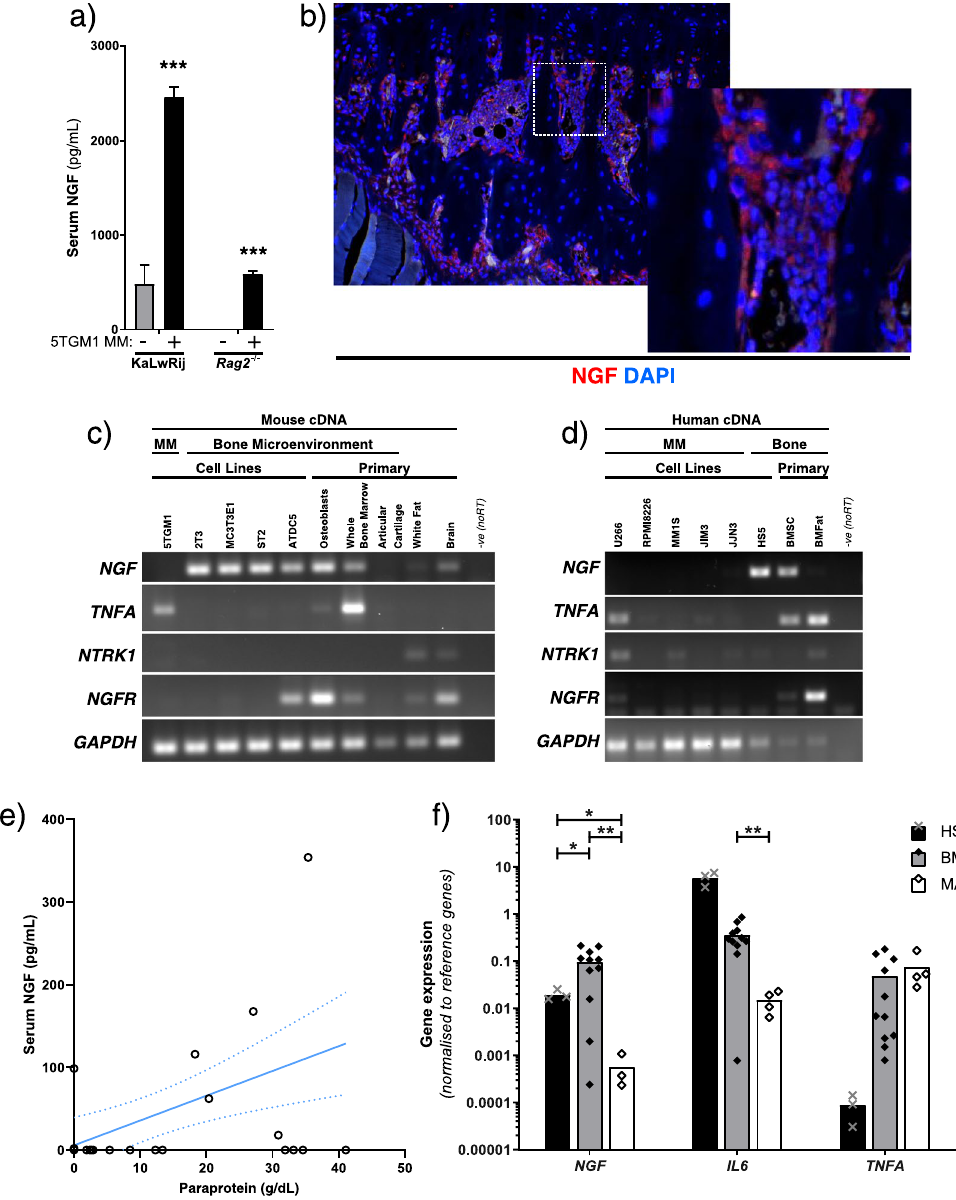
Figure 1. Increase in pain-related factors in multiple myeloma. ( a ) Serum NGF was detected by ELISA before inoculation or 25 days after 5TGM1-GFP + inoculation of C57Bl6/KaLwRij or Rag2 − / − mice. Statistical comparisons by t -test with Holm-Sidak multiple comparisons correction. ( b ) Immunofluorescent detection of NGF (red channel) in tibia of KaLwRij mice, counterstained with DAPI (blue channel). Magnified inset image corresponds to dashed box. ( c ) RT-PCR for mouse NGF , TNFA , NTRK1 (TrkA), NGFR (p75NTR) and GAPDH transcripts in the 5TGM1 MM cell line, bone stromal cell lines ST2, MC3T3e1, 2T3 and ATDC5, and primary tissue extracted from non-tumour-bearing KaLwRij mice as indicated. ( d ) RT-PCR for human homologs of the same transcripts in MM cell lines U266, RPMI8226, MM1S, JIM3 and JJN3, bone stromal cell line HS-5, and primary human BMSC or MAT cells. Gel images are cropped from different exposures, original uncropped images are available as Supplementary Material. ( e ) Serum NGF concentrations in MGUS and MM patients were quantified by ELISA, and tested for correlation with serum paraprotein levels as a marker of tumour burden. Pearson’s r correlation coefficient and p value shown. ( f ) Taqman qRT-PCR for NGF , IL6 and TNFA in the HS-5 cell line and primary patient-derived BMSC and MAT samples, relative to the average of two reference genes ( GAPDH and POLR2A ). Statistical comparisons per gene by one-way Brown-Forsythe and Welch ANOVA (for non-equal SD), with Dunnett’s multiple comparisons test. All statistical comparisons: ns : not significant, * p < 0.05; ** p < 0.01; *** p <